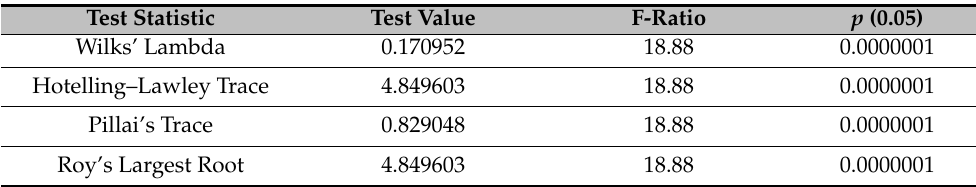
the localities names.